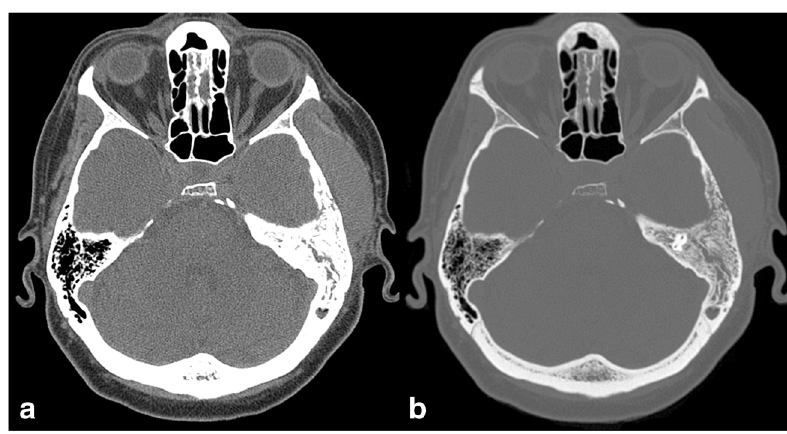
Fig. 11 Primary lymphoma of the bone. Axial CT images with soft tissues ( a ) and bone ( b ) windows highlight the presence of a bone lesion of the squamous portion of the left temporal bone, with lytic permeative pattern, extending to temporal extracranial soft